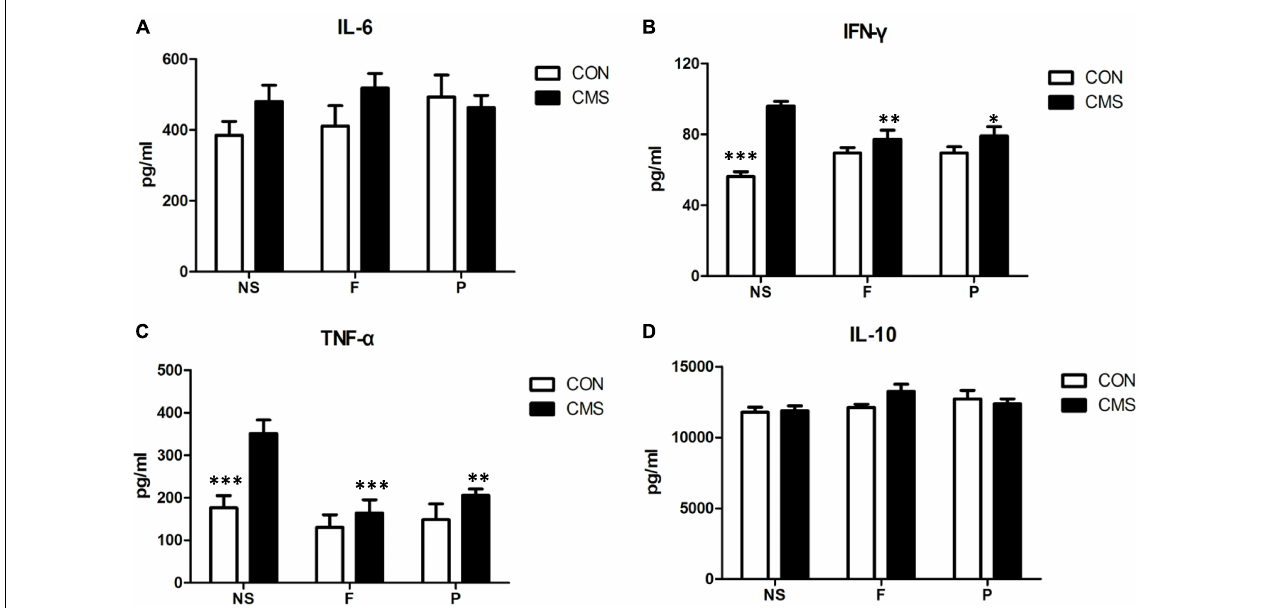
FIGURE 4 | Cytokine concentrations in the hippocampus. (A) There was no significant difference in hippocampal IL-6 level among six groups. (B) CMS significantly increased IFN- γ expression in the hippocampus, which could be reversed by supplementation with probiotics or fluoxetine. (C) CMS significantly increased TNF- α level in the hippocampus, which could be reversed by supplementation with probiotics or fluoxetine. (D) There was no significant difference in hippocampal IL-10 level among six groups. Data are presented as mean ± SEM; n = 8 per group; ∗ P < 0.05, ∗∗ P < 0.01, ∗∗∗ P < 0.001 vs. the CMS + NS group.